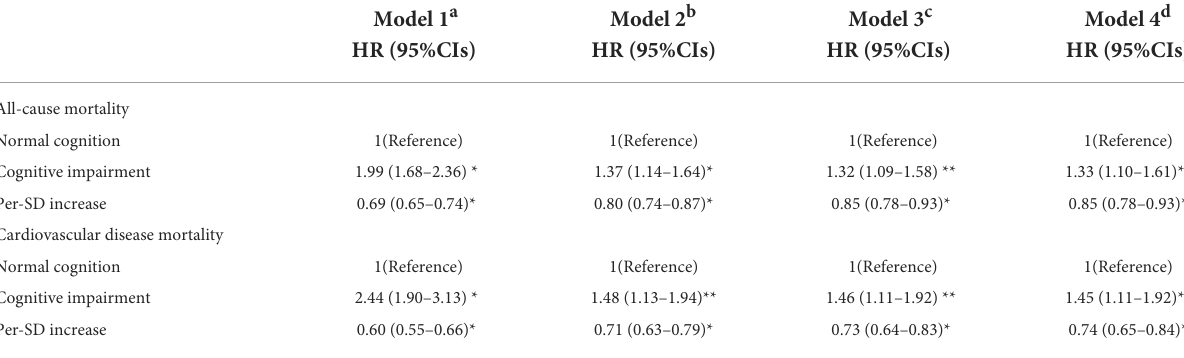
TABLE 2 Hazard ratio for the association between cognitive function with all-cause and CVD mortality.